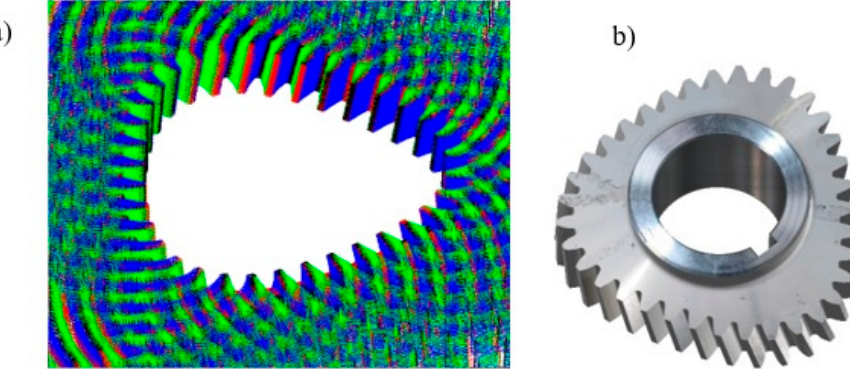
Figure 6. ( a ) Schematic diagram of the hobbing process; ( b ) common tangent plane of hobbing. ω c : angular velocity, Δω c : extra angular velocity, v d : diagonal feed rate, v : velocity, ω b : lead angle, β c : helical angle [12].